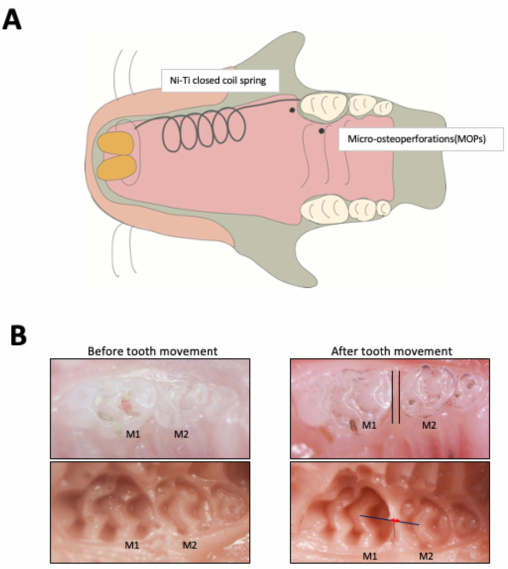
Figure 1. Orthodontic tooth movement and region of MOPs in mice: ( A ) Schematic of the appliance fixed between incisors and the first molar in mice and MOPs. One MOP (black dot) was placed about 1.0 mm mesial to the maxillary left first molar. The other MOP (black dot) was placed about 1.0 mm palatal to the maxillary left first molar. ( B ) Pictures of tooth movement and measurement of OTM in mice. The red double arrow between the maxillary left first molar (M1) and maxillary left second molar (M2) on the solid line connecting the central fossae of the two molars in silicone impressions was evaluated by stereoscopic